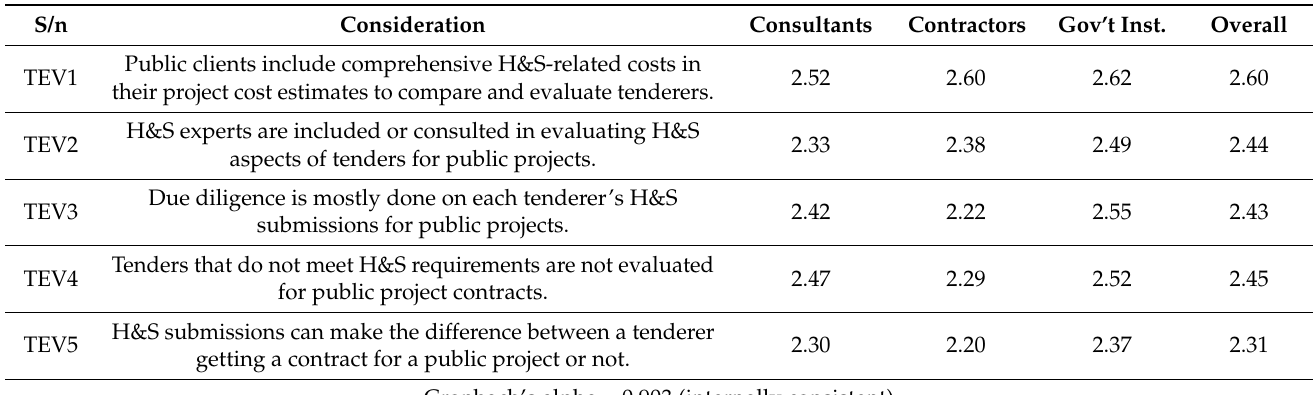
Table 8. H&S considerations at tender evaluation.